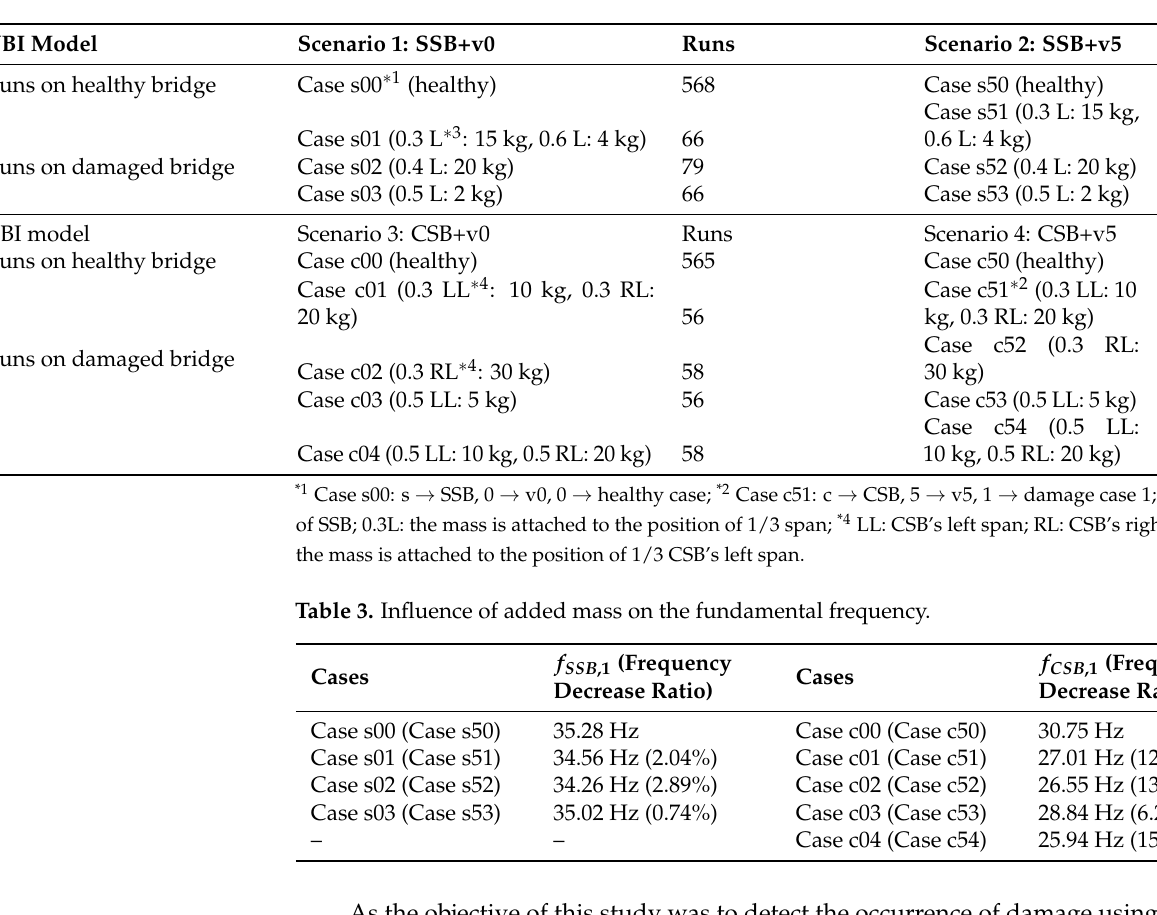
Table 2. Cases in the experiment.